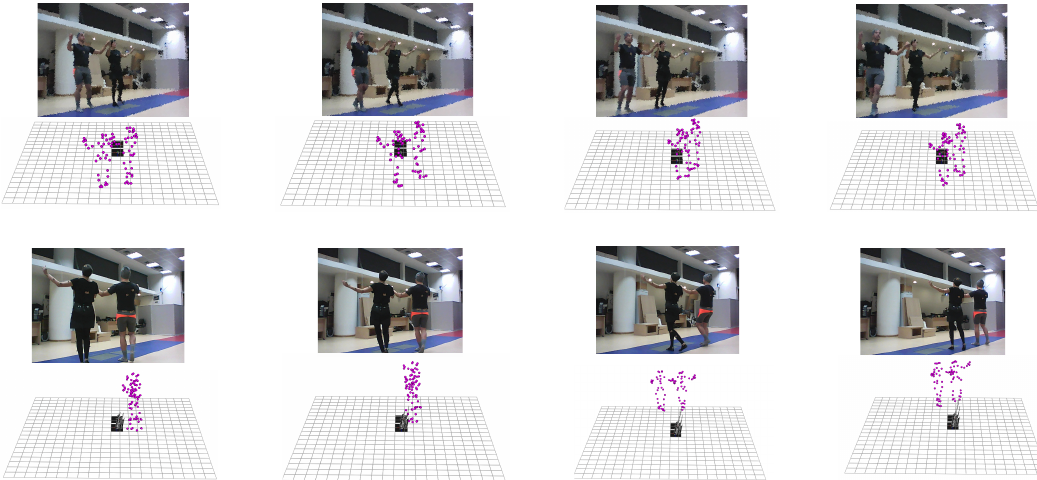
Figure 1. An example of geometric challenges due to the presence of multiple dancers.